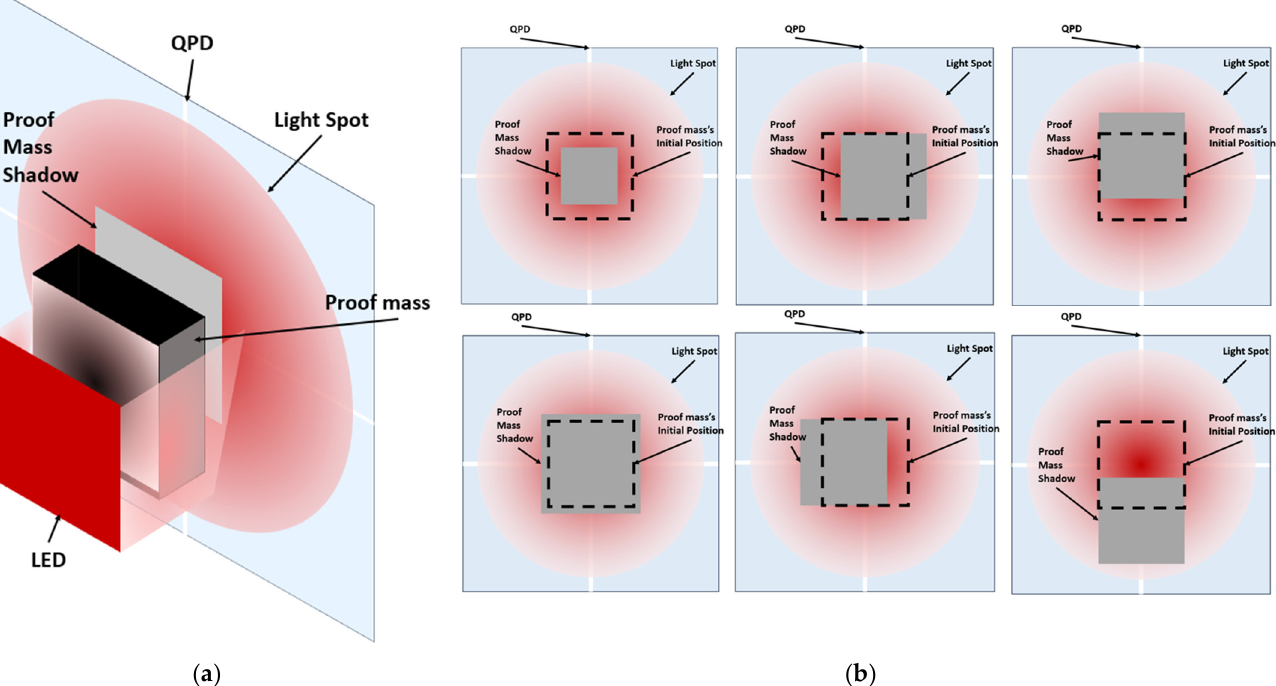
Figure 3. ( a ) Isometric drawing of the optical concept of the accelerometer. ( b ) The shadow position moves with the proof mass position and the optical power received by each quadrant of the QPD changes. The dimensions are not to scale.